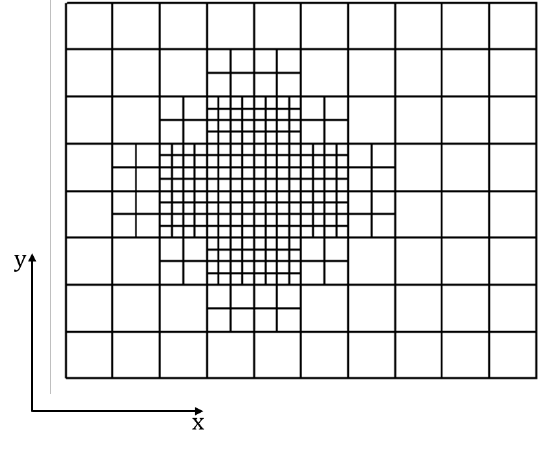
Figure 1. Example of non-uniform rectangular